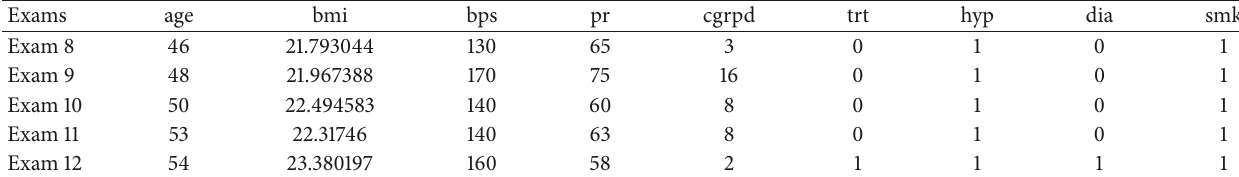
Table 11: Exam data for Sample 4: female with CVD and